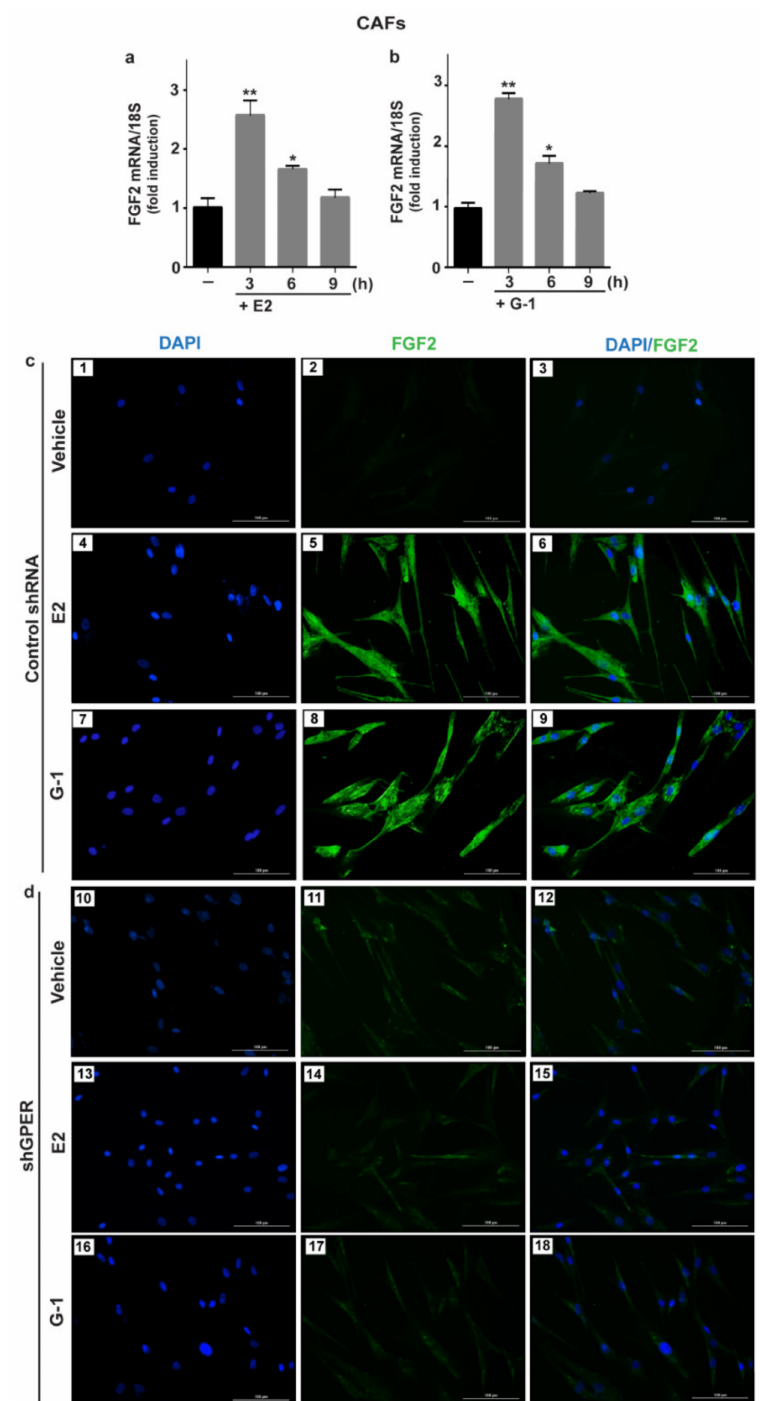
Figure 1. E2 and G-1 induce FGF2 expression through GPER in CAFs. 10 nM E2 ( a ) and 100 nM G-1 ( b ) induced FGF2 mRNA expression, as evaluated by quantitative PCR (qPCR). Values were normalized to 18S expression and shown as fold changes of FGF2 mRNA expression upon E2 and G-1 treatments respect to cells exposed to vehicle (). Each column represents the mean ± standard deviation (SD) of three independent experiments performed in triplicate. (**) indicates p < 0.01 and (*) indicates p < 0.05. ( c , d ) FGF2 protein expression by immunofluorescence in CAFs transfected for 24 h with control shRNA (panels 1–9) or sh G protein estrogen receptor (shGPER) (panels 10–18) and then treated for 6 h with vehicle, 10 nM E2 and 100 nM G-1, as indicated. FGF2 accumulation is shown by the green signal, nuclei are stained by 4, 6-diamidino-2-phenylindole dihydrochloride (DAPI) (blue signal), scale bar = 100 µ m. Images shown are representative of two independent